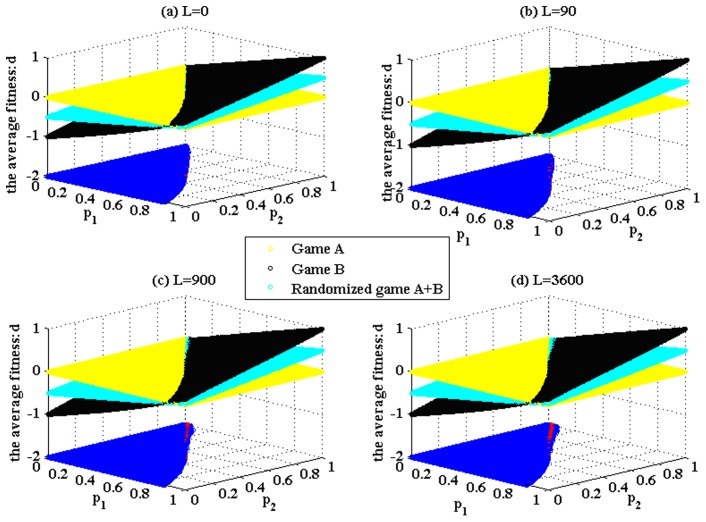
Simulations based on the networks, which progressively change from a two-dimensional lattice to a random network.The population size N is 900. The average degree of the network is four, and the average number of playing times T of each individual is 100. The probability of playing game A is p = 0.5. Play the games 30 times with different random numbers, and draw the corresponding figures according to the average results of the games. The blue area in the picture demonstrates the weak Parrondo’s paradox area, whereas the red denotes the strong area. Figures 4 (a), (b), (c) and (d) correspond to the networks with the rewiring times L = 0, 90, 900 and 3,600, respectively.